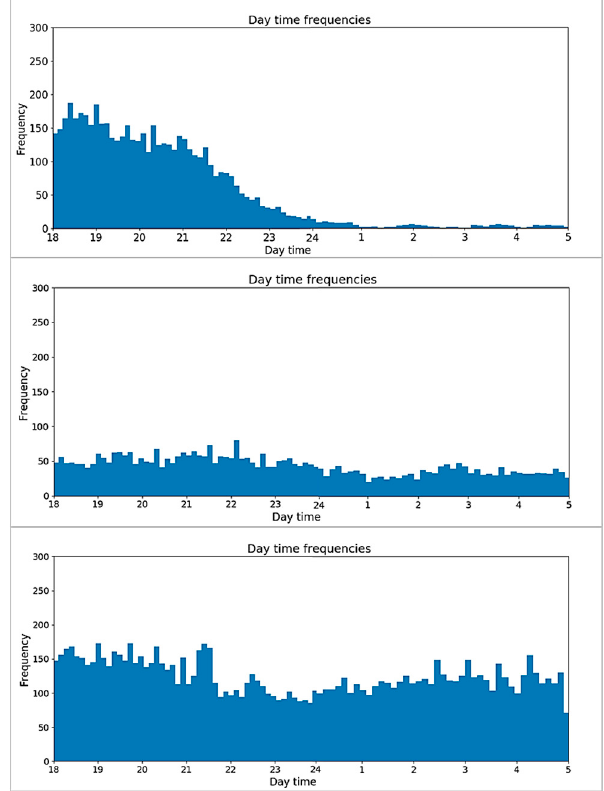
Figure 5. Individual day time frequencies of plays for different users during the evening intervals.